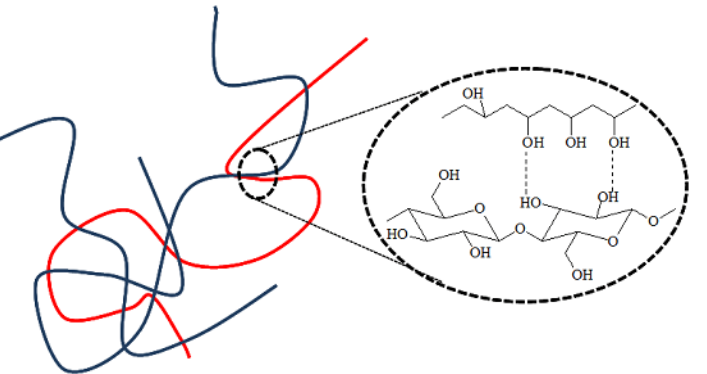
Figure 3. Schematic structure of BNC/PVA composite: physical cross-linking (chain entanglement, hydrogen bonds).